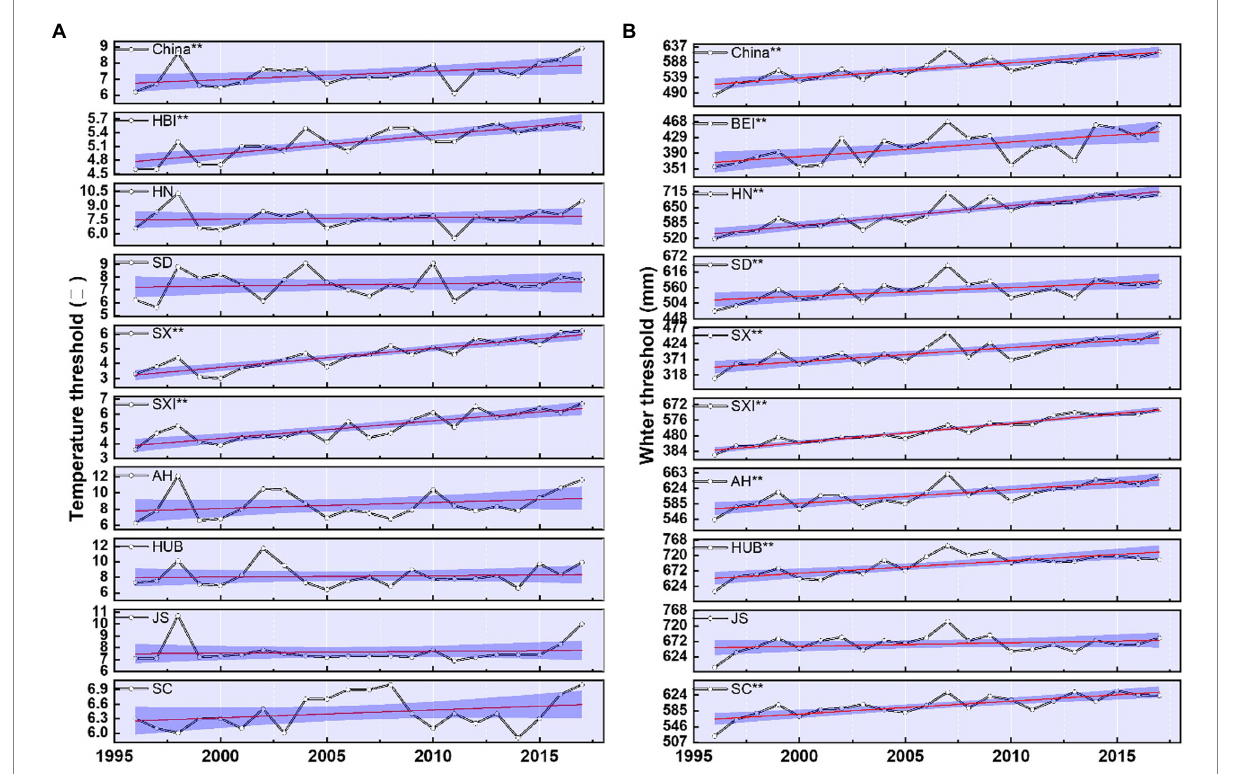
FIGURE 6 The optimal threshold temperature (A) and precipitation (B) trends for winter wheat from 1996 to 2017.